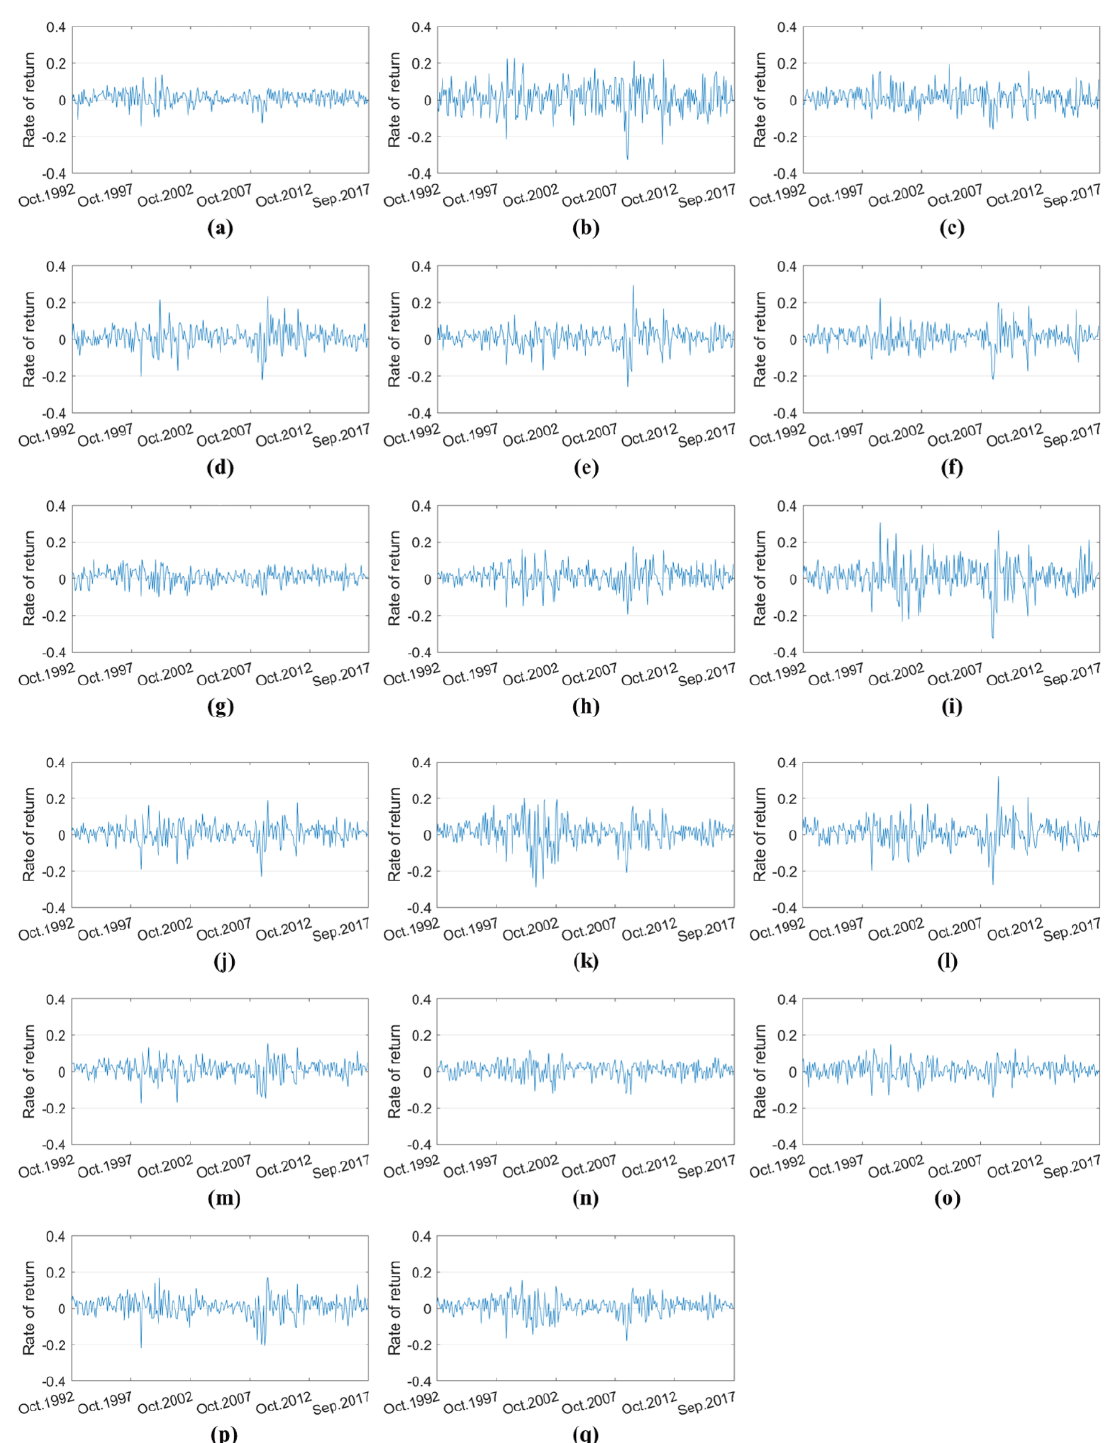
Figure A1. Time-series graphs of returns by 17 industry portfolios from October 1992 to September 2017. ( a ) Food; ( b ) Mining and Mineral (Mines); ( c ) Oil and Petroleum Products (Oil); ( d ) Textiles, Apparel & Footwea (Clths); ( e ) Consumer Durables (Durbl); ( f ) Chemicals (Chems); ( g ) Drugs, Soap, Perfumes, Tobacco (Cnsum); ( h ) Construction and Construction Materials (Cnstr); ( i ) Steel Works Etc (Steel); ( j ) Fabricated Products (FabPr); ( k ) Machinery and Business Equipment (Machn); ( l ) Automobiles (Cars); ( m ) Trans Transportation (Trans); ( n ) Utilities (Utils); ( o ) Retail Stores (Rtail); ( p ) Banks, Insurance Companies, and Other Financials (Finan); ( q )